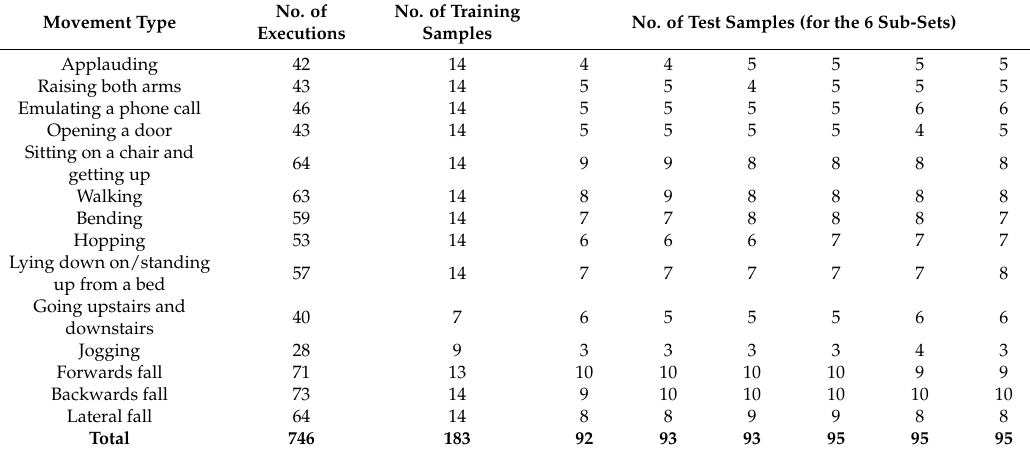
Table 2. Typology and number of the movements executed by the experimental subjects during the testbed. The table also indicates the number of samples utilized for both training and testing phases during the validation of the machine learning algorithms.